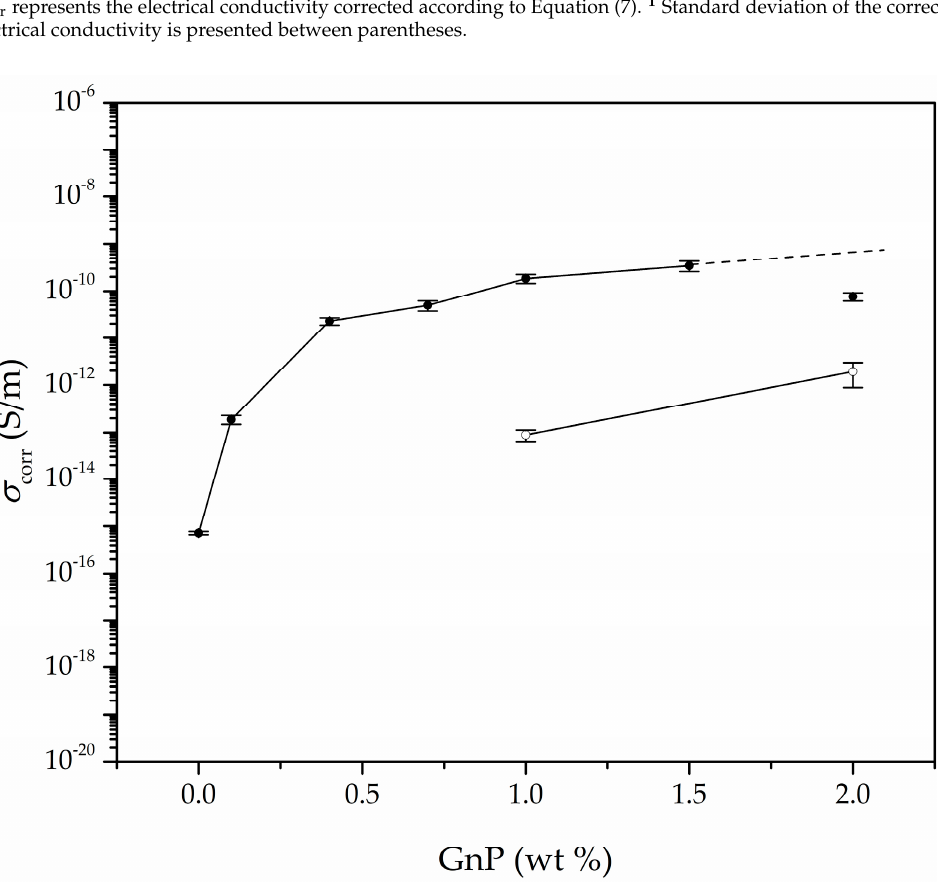
Figure 7. Electrical conductivity enhancement of PEI and PEI-GnP nanocomposite foams with increasing GnP amount. Black circles represent the electrical conductivity values corresponding to foams prepared by one-step scCO 2 foaming and white circles correspond to the electrical conductivity of foams prepared by WVIPS [6].